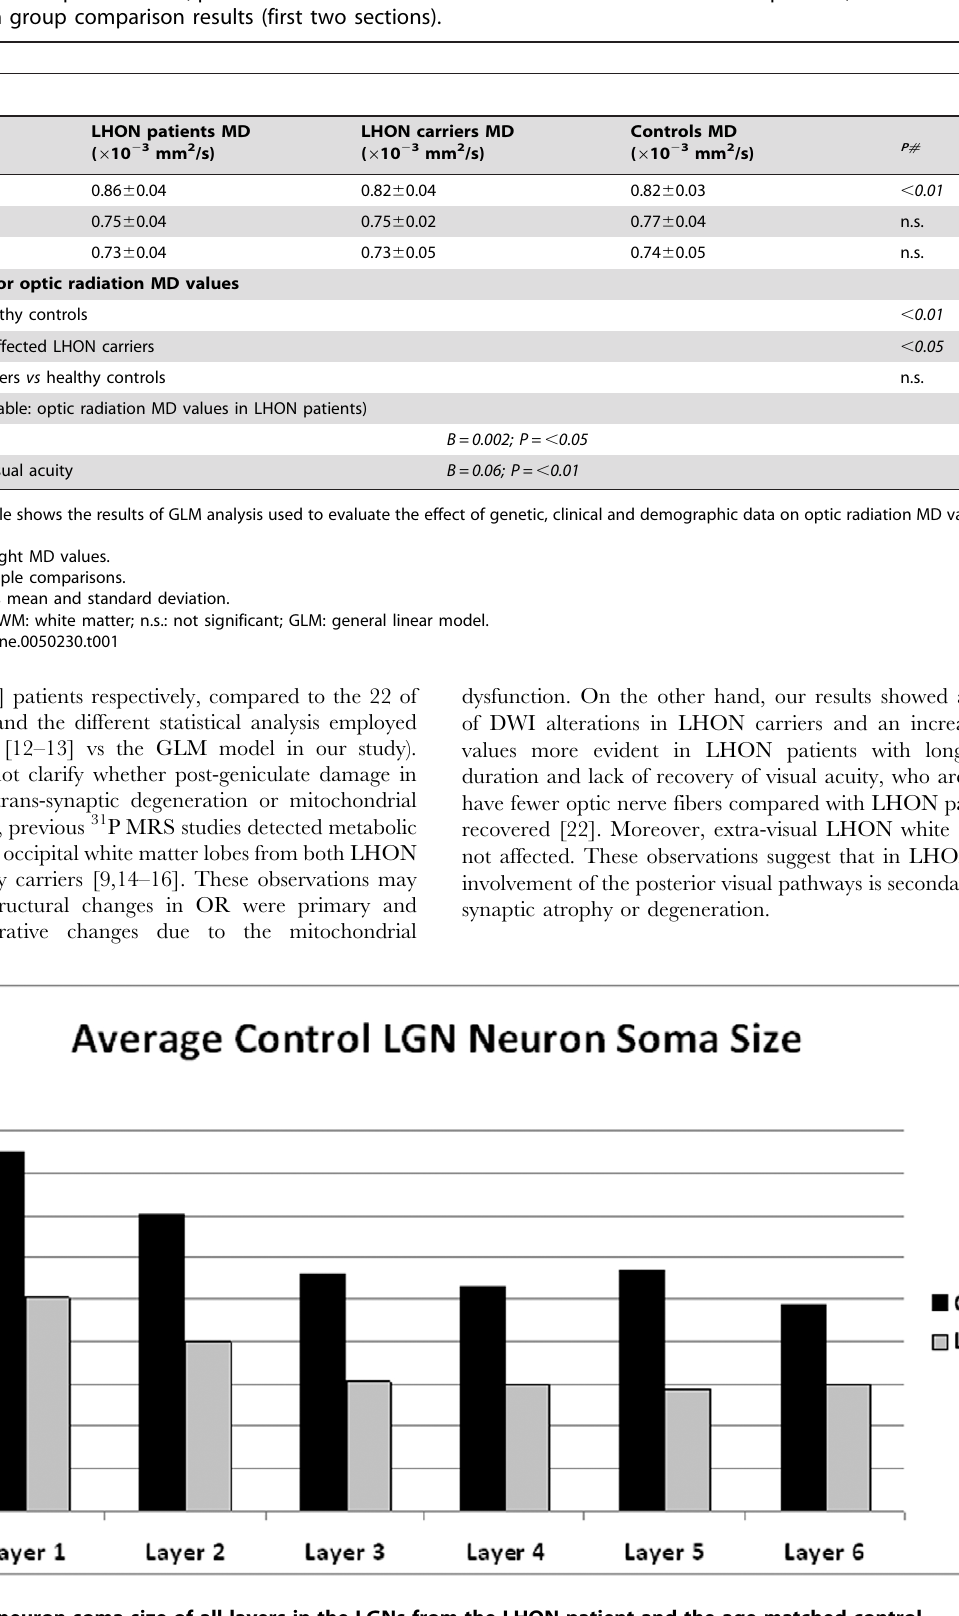
Figure 3. Average neuron soma size of all layers in the LGNs from the LHON patient and the age-matched control. doi:10.1371/journal.pone.0050230.g003 PLOS ONE |